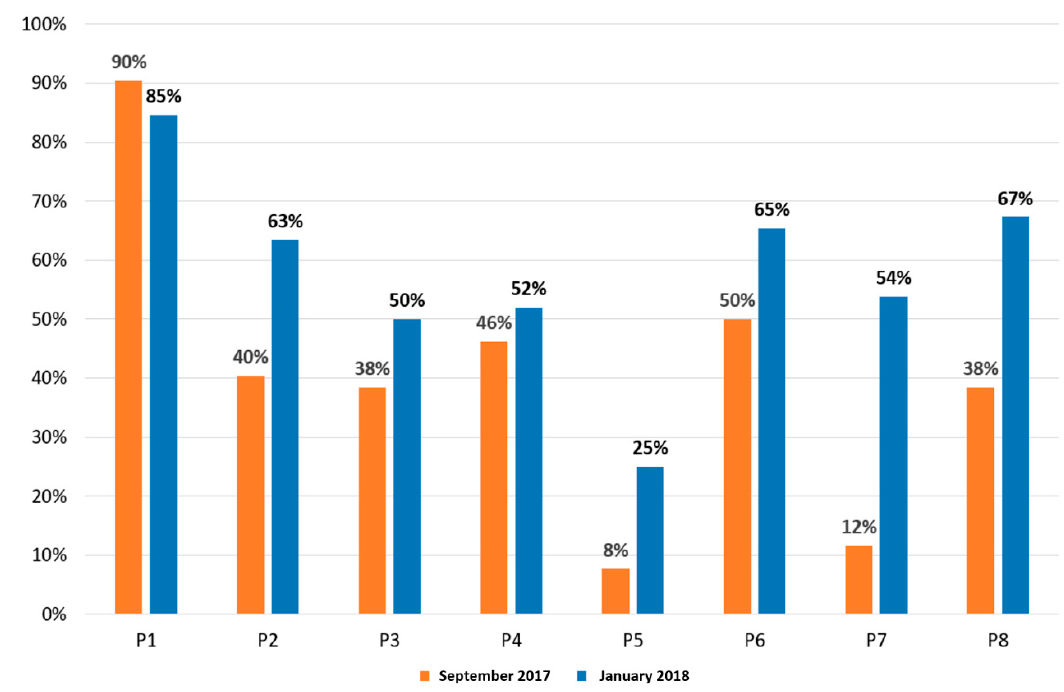
Figure 3. Percentage of hits on each of the questions in September 2017 and January 2018.